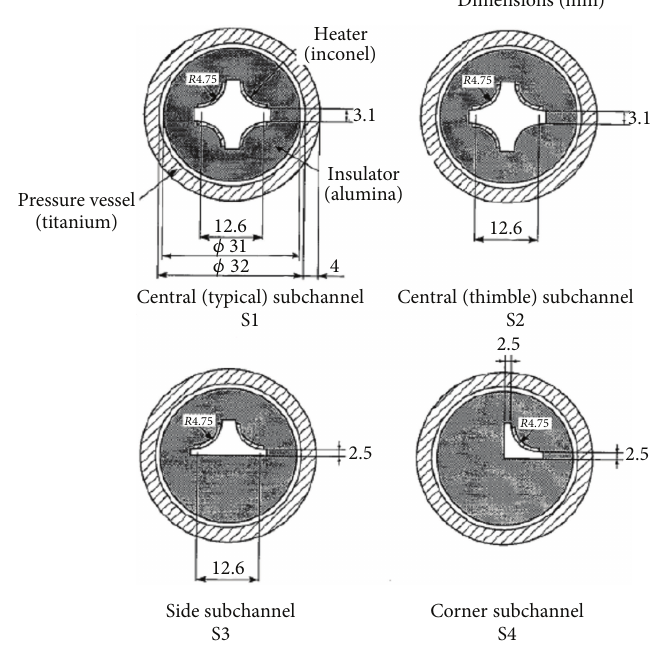
Figure 3: Cross-sectional view of subchannel test